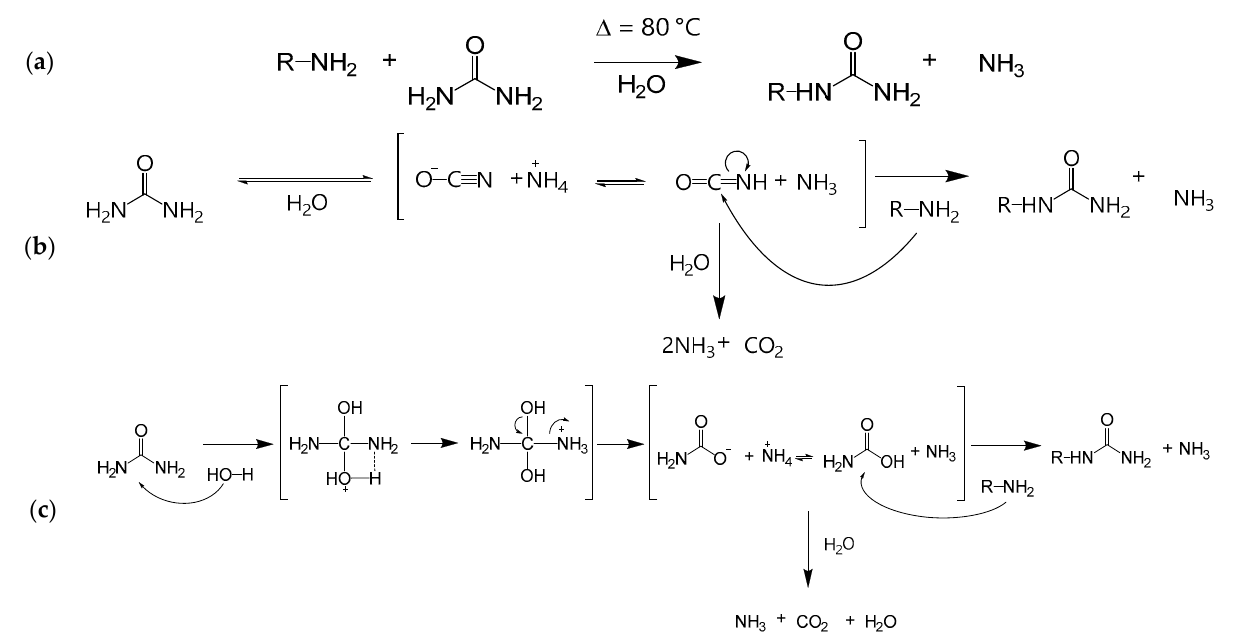
Scheme 1. ( a ) General reaction of a primary amine with urea at 80 °C in aqueous solution to form a ureido product, ( b ) mechanism of amine with urea reaction via in situ formation of isocyanic acid in aqueous solution, and ( c ) mechanism of amine with urea reaction via urea hydrolysis.